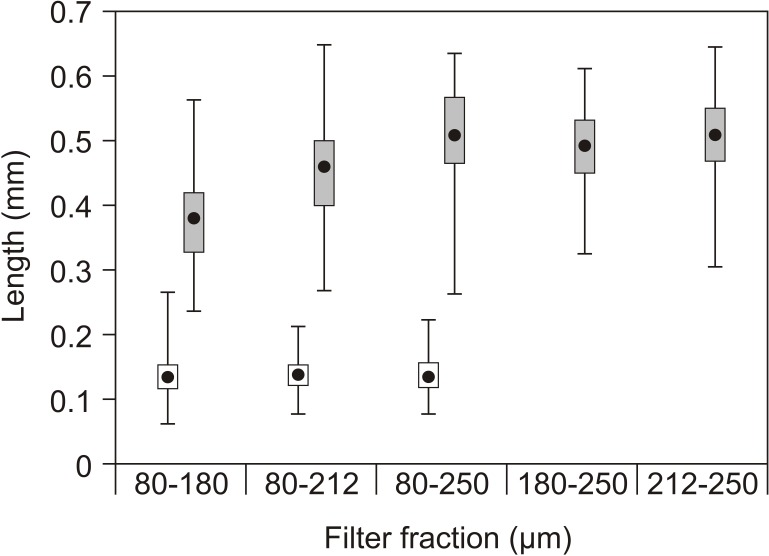
Copepod size fractions.Mean prosome (copepodids) or total length (nauplii), quartiles (box) and range (lines) of nauplii (open) and copepodids (grey) in the different filter fractions used as feed in the experiments. No nauplii were present in the 180–250 µm or 212–250 µm fractions.